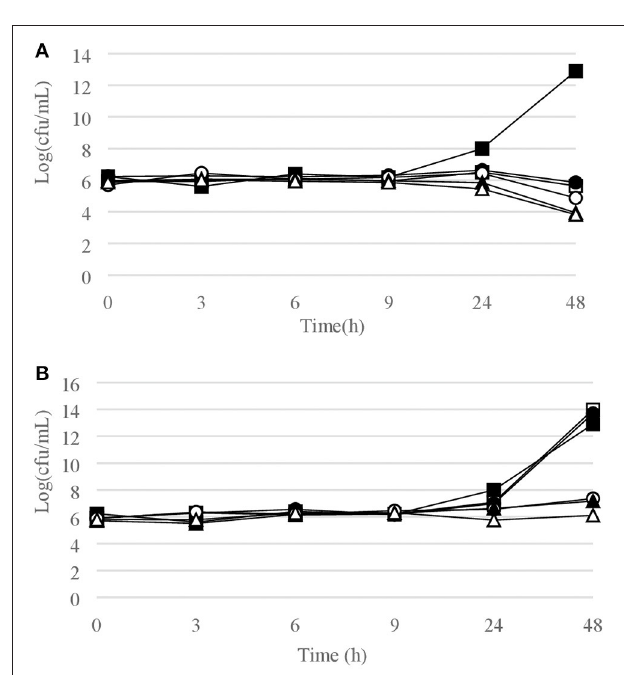
FIGURE 3 | Time-kill curves for (A) S. pyogenes , chlorquinaldol; (B) E. faecalis , chlorquinaldol. Filled square, control; open square, ¼ × MIC; filled circle, ½ × MIC; open circle, 1 × MIC; filled triangle, 2 × MIC; open triangle, 4 × MIC.